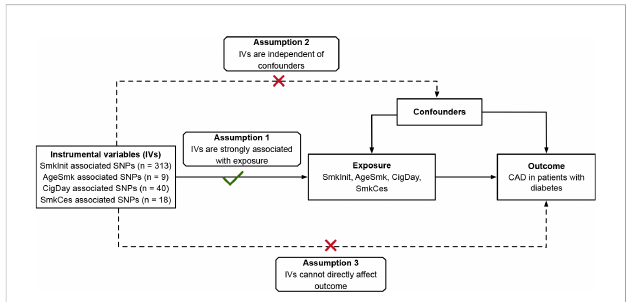
FIGURE 1 Conceptual schematics for the design of Mendelian randomization study. IV indicates instrumental variables; SmkInit, smoking initiation; AgeSmk, age at initiation of regular smoking; CigDay, cigarettes per day; SmkCes, smoking cessation; CAD, coronary artery